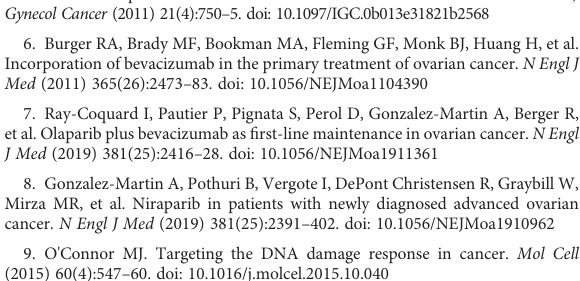
SUPPLEMENTARY FIGURE 1 Association of sNRP-1 with BRCA1/2 mutational status and CA125. (A) Scatter plots with sNRP-1 levels of patients with known BRCA1/2 mutational status are shown with BRCA1/2 mutations ( mBRCA1/2 , n =15) and wild-type BRCA1/2 status ( wtBRCA1/2 , n = 24), p = 0.97. (B) The correlation of sNRP-1 and log (CA125) is shown, using non- parametric Spearman correlation (n = 88, p = 0.04) with simple linear regression (red line). SUPPLEMENTARY FIGURE 2 Prognostic information of sNRP-1 using an optimized cut-off. Kaplan- Meier analysis of patients with ovarian cancer comparing (A) cumulative progression-free survival according to sNRP-1 low (n = 42) and sNRP-1 high (n = 46), optimized cut-off PFS: 2.3195 nmol/L and (B) cumulative overall survival (OS) according to sNRP-1 low (n = 77) and sNRP-1 high (n = 11), optimized cut-off: 2,9805 nmol/L. HR and 95%CI determined by Mantel Haenszel and p-value by log-rank (Mantel-Cox), as described in the methods section. (C) Results from univariate and multivariate Cox proportional hazard regression model analyses for PFS of sNRP-1 low (n = 42) vs . sNRP-1 high (n = 46) are shown, including hazard ratio (HR) and 95%CIs and p-values. (D) Scatter plot is shown with sNRP-1 low (n = 42) and sNRP-1 high (n = 46) according to an optimized cut-off determined by maximally selected rank statistics for PFS, p < 0.0001. The black horizontal lines indicate the median sNRP-1 levels in each group with error bars, showing the 95%CI. P-value according to the non-parametric, two ‐ sided Mann-Whitney test. (E) Graphical representation of cut-off determination by maximally selected rank